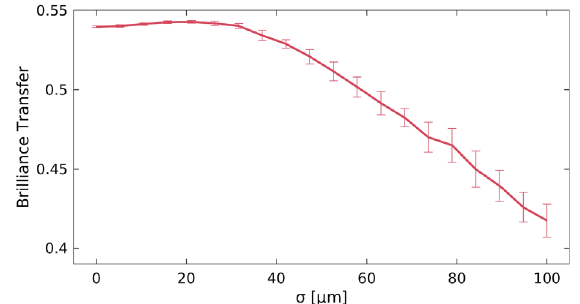
FIG. 10. Brilliance transfer as a function of the random misalign- ment. Brilliance transfer is average in the range 2.3 – 4.0 Å.